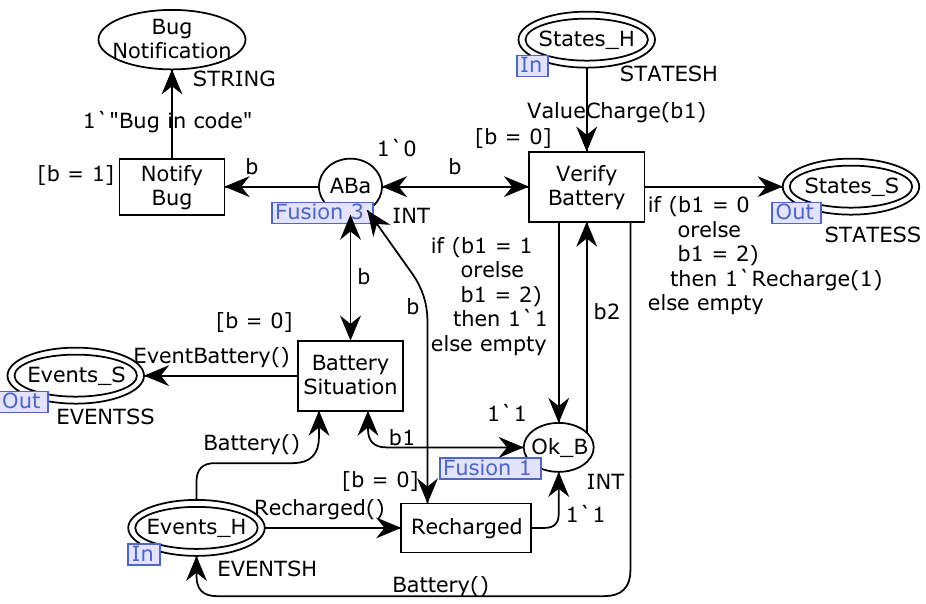
Figure 7. Verify Battery module of the first system